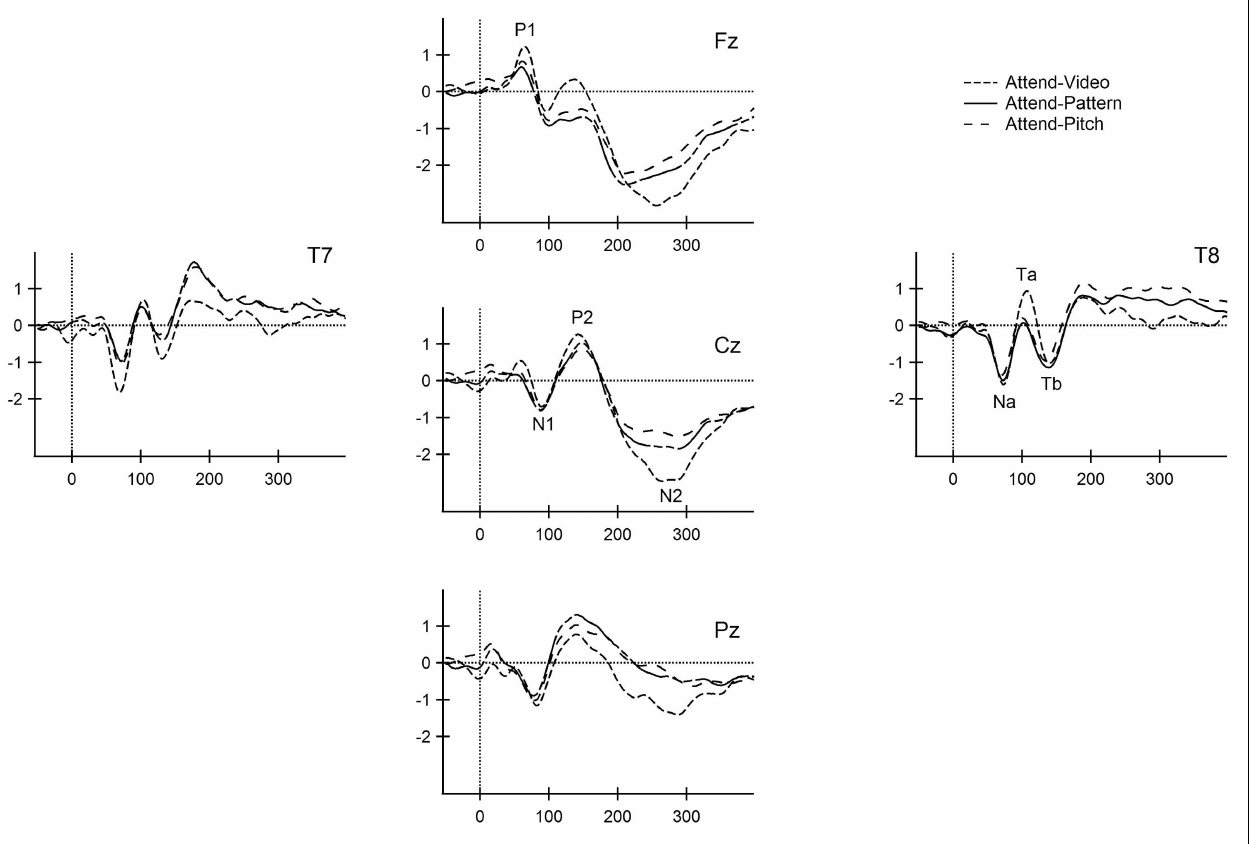
Obligatory ERP components are labeled at the electrode of greatest signal-to-noise ratio for the midline (P1, N1, P2, and N2) and the t -complex (Na,Ta, andTb). x-axis is displayed in milliseconds. y-axis is the amplitude in